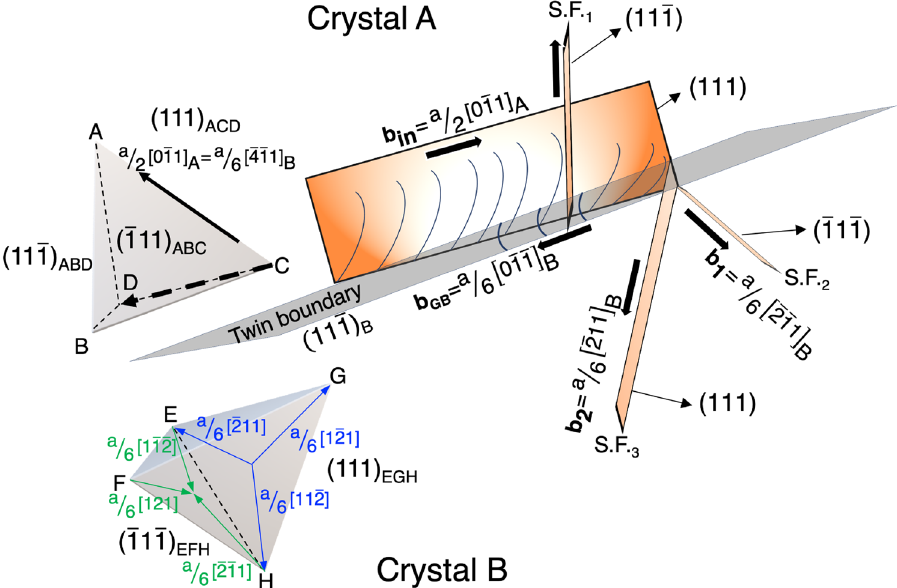
Figure 6. A schematic illustration shows the precursors of deformation twin are initiated at a near grain boundary region as a result of the impingement between piled-up dislocations and an annealing twin boundary. The stacking fault S.F. 1 is formed by a cross-slip dislocation reaction. S.F. 2 and S.F. 3 are formed by a grain boundary stress relaxation reaction. The Burgers vector of incoming dislocations b in was designated to be a / 2[0 ¯ 11] A or a / 6[ ¯ 4 ¯ 11] B after a proper matrix transformation, whereas the Burgers vectors of b assumed to be two Shockley partial dislocations ( a / 6 (cid:31) ¯ 2 ¯ 11 (cid:30) B and a / 6 (cid:31) ¯ 211 (cid:30) B ) that are emitted to minimize the magnitude of Burgers vector of grain boundary